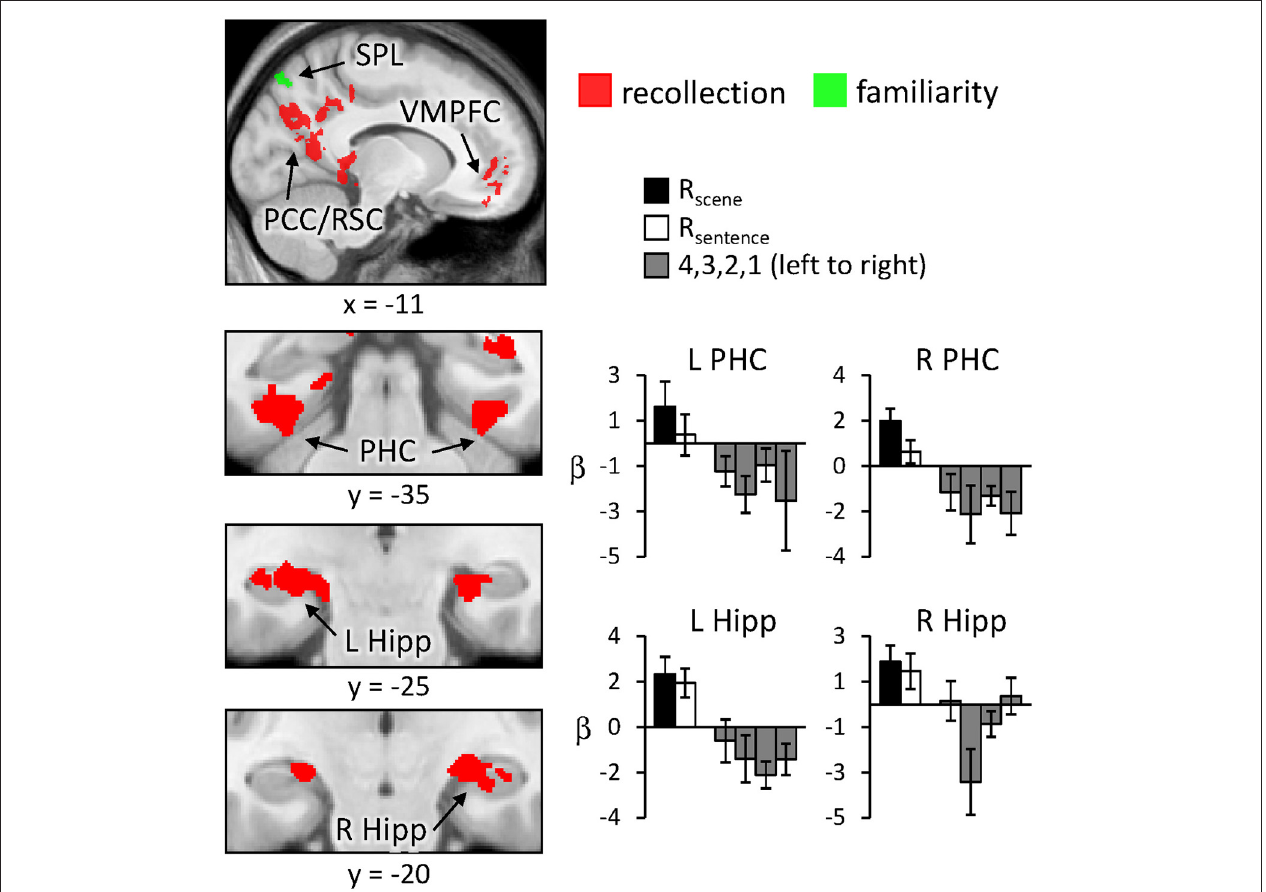
lobe (bottom row) are shown on magnified portions of coronal slices, the locations of which are indicated by dotted lines (lower left). SPL (superior parietal lobule), PCC/RSC (posterior cingulate cortex/retrosplenial cortex), VMPFC (ventromedial prefrontal cortex), PHC (parahippocampal cortex),